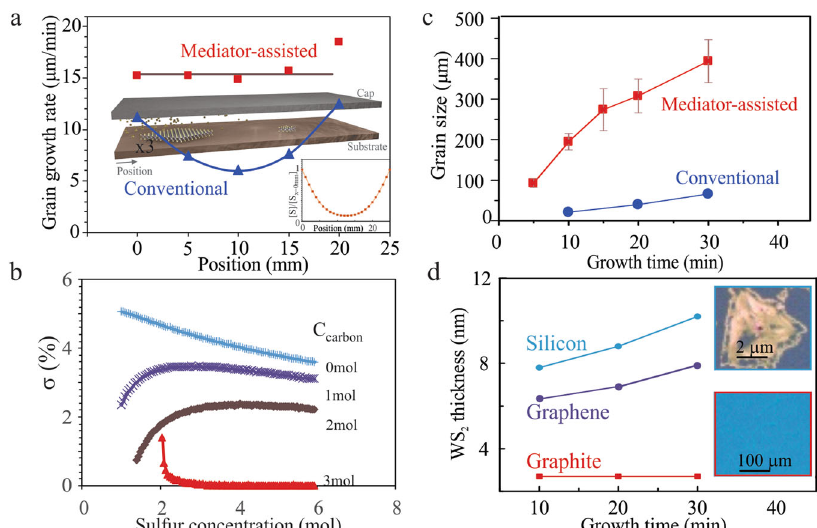
Fig. 2 Mediator-assisted growth process. a Characterization of grain growth rate within close con fi nement for mediator-assisted and mediator-free growth, (center inset) depiction of pore with indication of position origin, (bottom right inset) calculated concentration of sulfur in the same setup according to Chen et al 22 . b Thermochemical simulation of sensitivity factor σ at different concentrations of carbon-based mediator (more details in text). c Time-dependent WS 2 grain size for mediator-assisted and unassisted CVD. d Time evolution of WS 2 thickness for different types of mediators, (inset) optical micrographs of WS 2 grown without a mediator (top) and with a graphite mediator